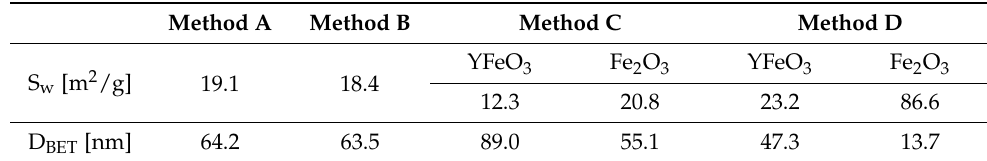
Table 1. Specific surface area and grain size.